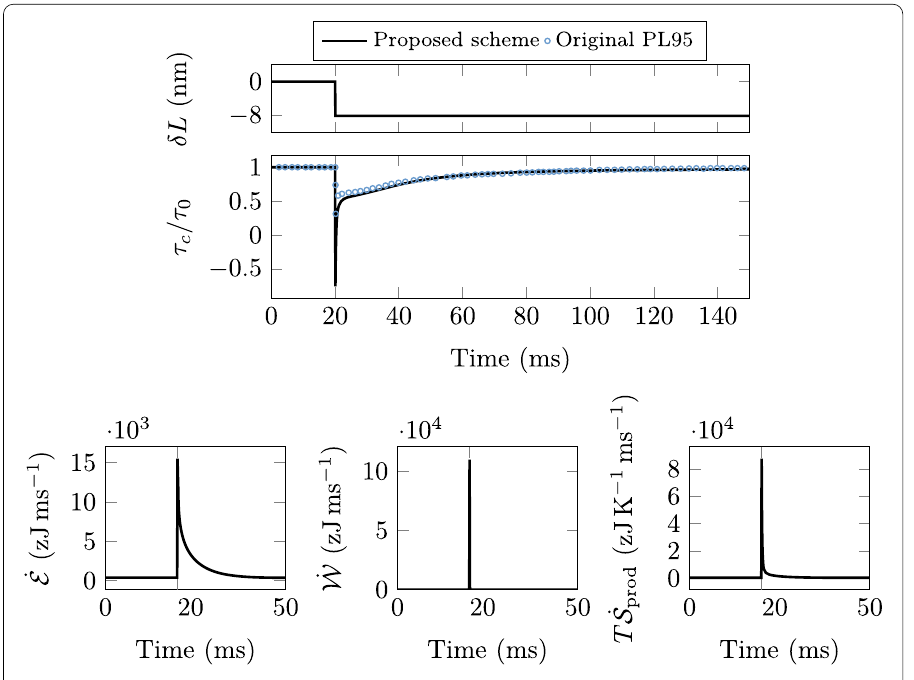
Fig. 11 Tension evolution and thermodynamic fluxes per myosin head in a length step experiment simulation with Piazzesi–Lombardi’95 model. The isometric tension is denoted by τ